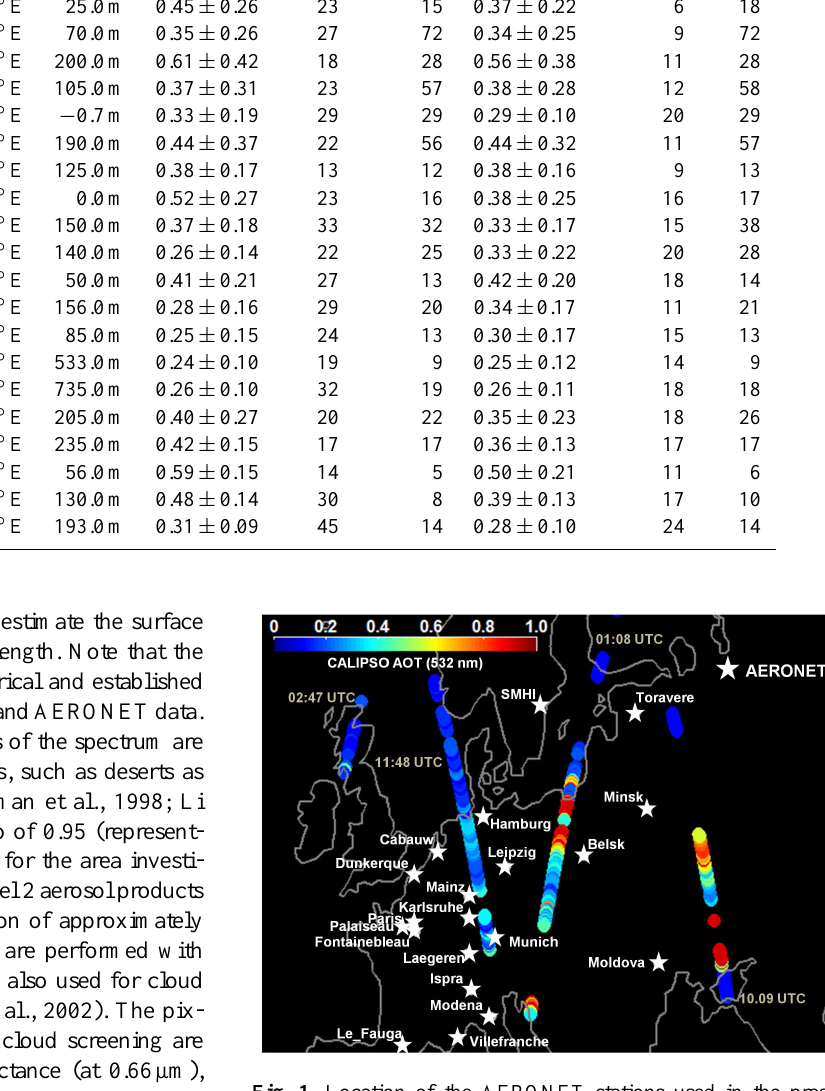
Fig. 1. Location of the AERONET stations used in the present study. The colored dots represent AOT at 532nm, obtained from CALIPSO measurements during day and night tracks on 1 April 2007. The approximate overpass times are provided for the individual tracks. AOTs are only shown for cases without clouds in the profile and for which a ground signal was